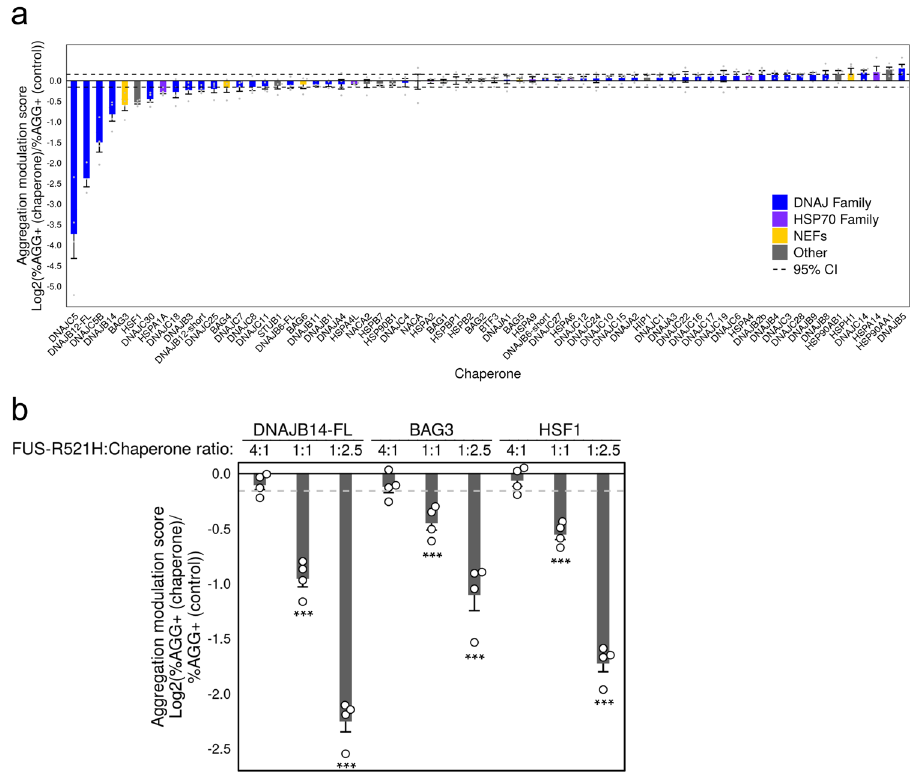
Fig. 3 A chaperone network screen identi fi ed modulators of mutant FUS aggregation. a Aggregation modulation scores for 66 chaperones revealed aggregation alleviators of mutFUS aggregation (negative scores, left side). Data are presented as mean values ± SEM of n = 4 biologically independent experiments for all chaperones, except for HSPA6 and DNAJB6-short ( n = 3). Gray dots represent individual data points. 95% con fi dence intervals marked with dashed lines (CI = ± 0.1577, representing 2*STD based on a total of n = 90 DsRed replicates). Chaperone families are color coded. Source data are provided as a Source data fi le. b Aggregation modulation showed a dose-dependent effect. Cells were co-transfected with different FUS-R521H- YFP:chaperone ratios, starting from high ratios of mutFUS DNA:chaperone DNA (2000 ng/500 ng, respectively), equal DNA amounts as in the screen (1250 ng/1250 ng), and a low ratio (700 ng/1800 ng, respectively). Results demonstrated a dose-dependent rescue for all chaperones shown. Data are presented as mean values ± SEM of n = 4 biologically independent experiments. Dashed lines represent 95% CI as in ( a ). *** p < 0.003, empirical p-value (see “ Methods ” ). Source data are provided as a Source data fi